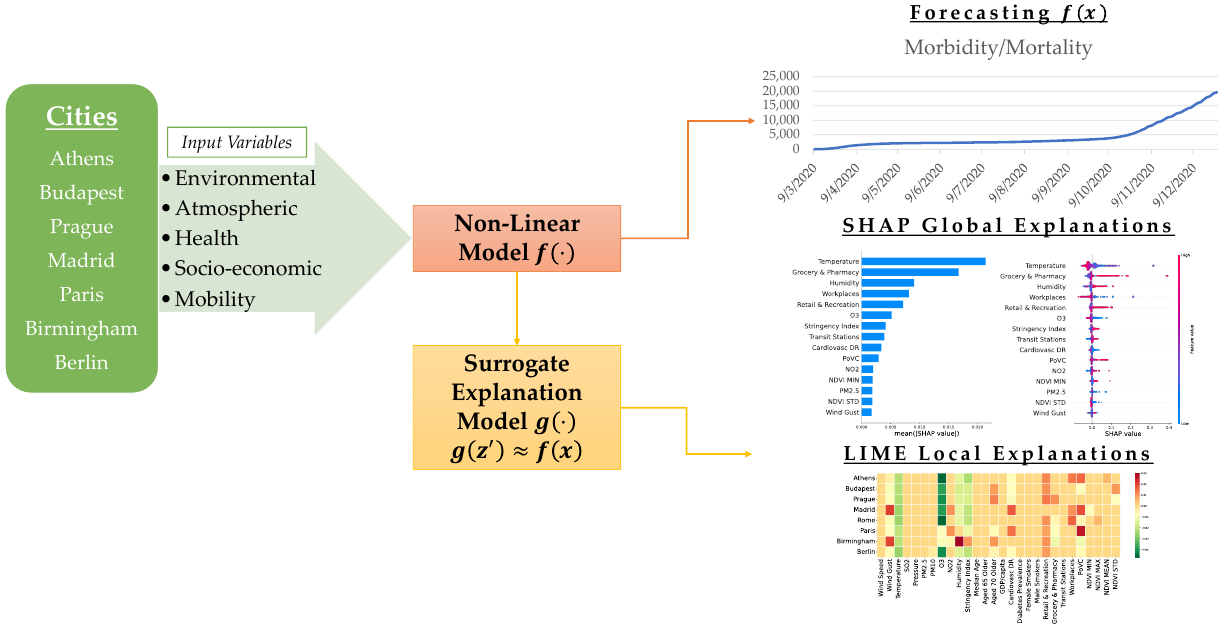
Figure 2. The proposed machine learning model is responsible for interpreting predictions on COVID- 19 daily cases and deaths. On one hand, the proposed model forecasts COVID-19 cases and deaths, and on the other hand it discovers possible links from SHAP and Lime explainability